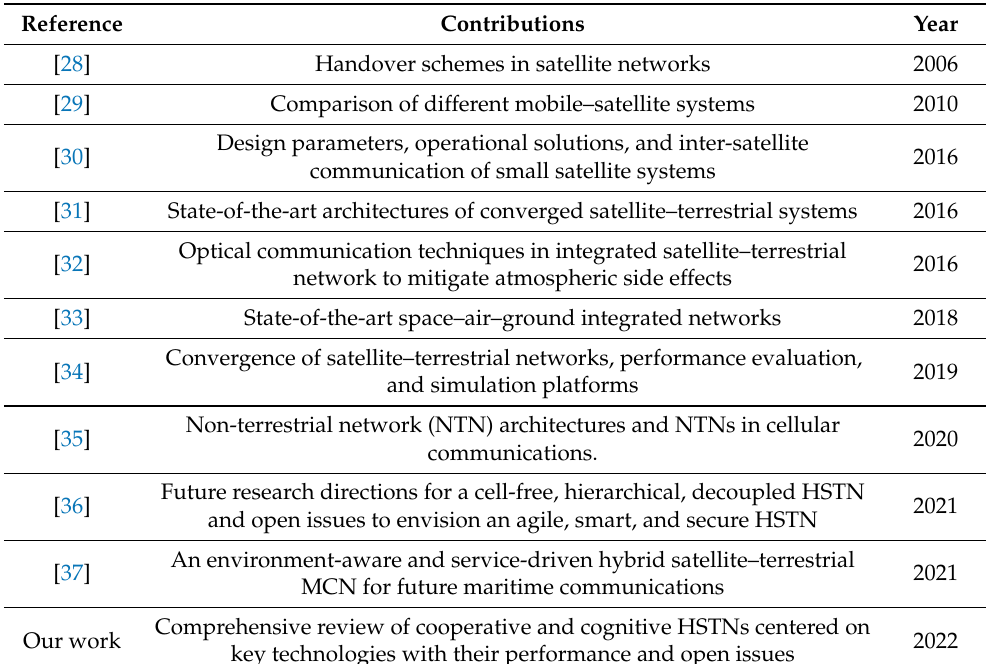
Table 2. Comparison of surveys of